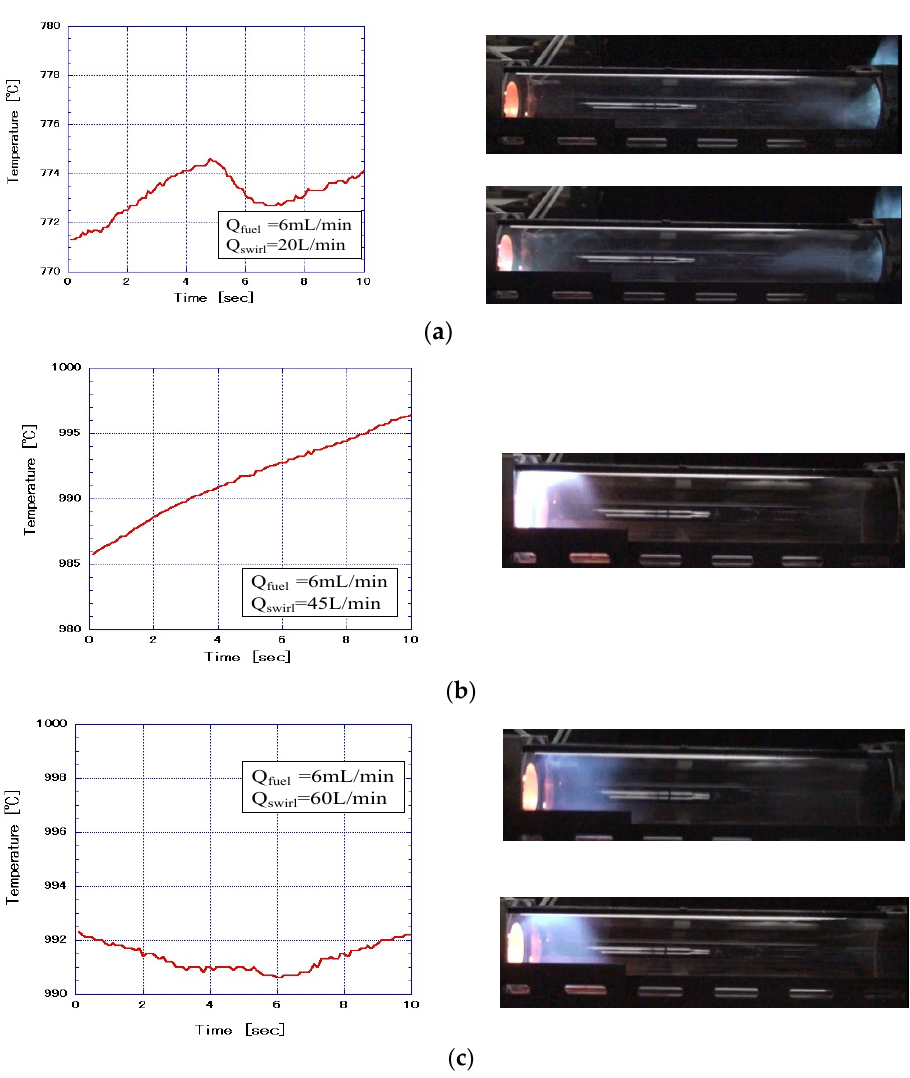
Figure 13. Temperature fluctuation in the combustion chamber (Q fuel = 6 mL/min fixed). ( a ) Q swirl = 20 L/min. ( b ) Q swirl = 45 L/min. ( c ) Q swirl = 60 L/min.